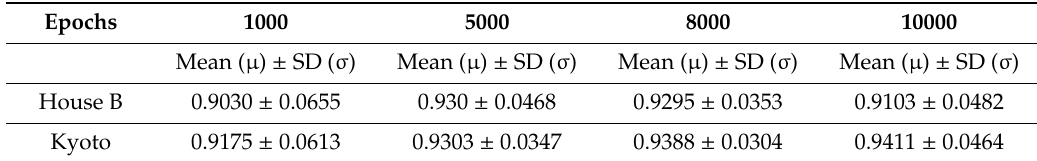
Table 6. Mean & Standard deviation of di ff erent Epcohs on 100 Batch Size.